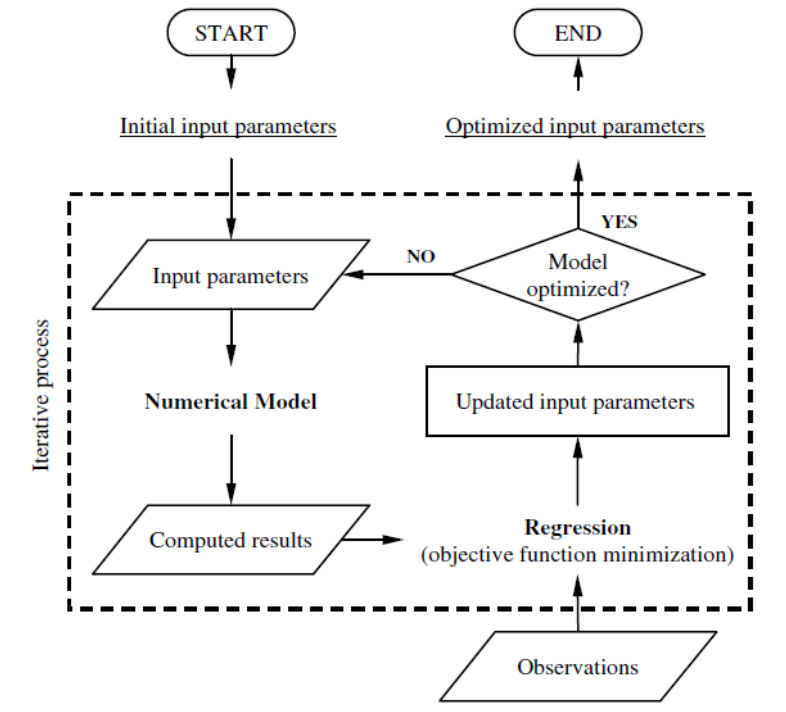
Figure 6. Schematic of inverse analysis procedure.